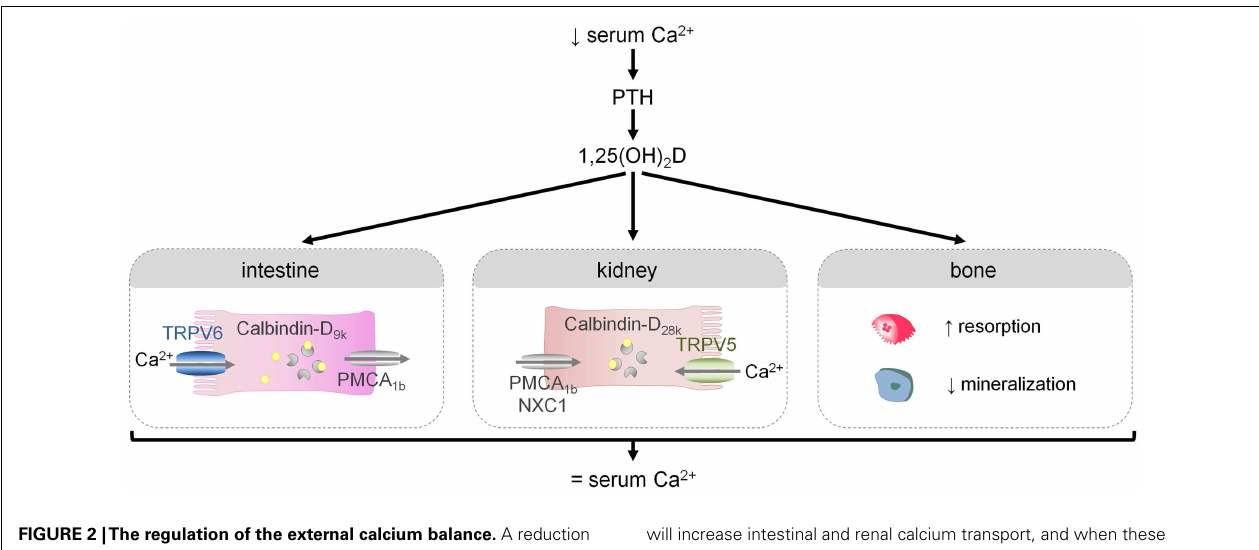
FIGURE 2 |The regulation of the external calcium balance. A reduction in serum Ca 2 + levels triggers the release of PTH and the production of 1,25(OH) 2 D, the active hormone. 1,25(OH) 2 D in turn modulates several processes that will ultimately lead to normalization of serum Ca 2 + levels: it